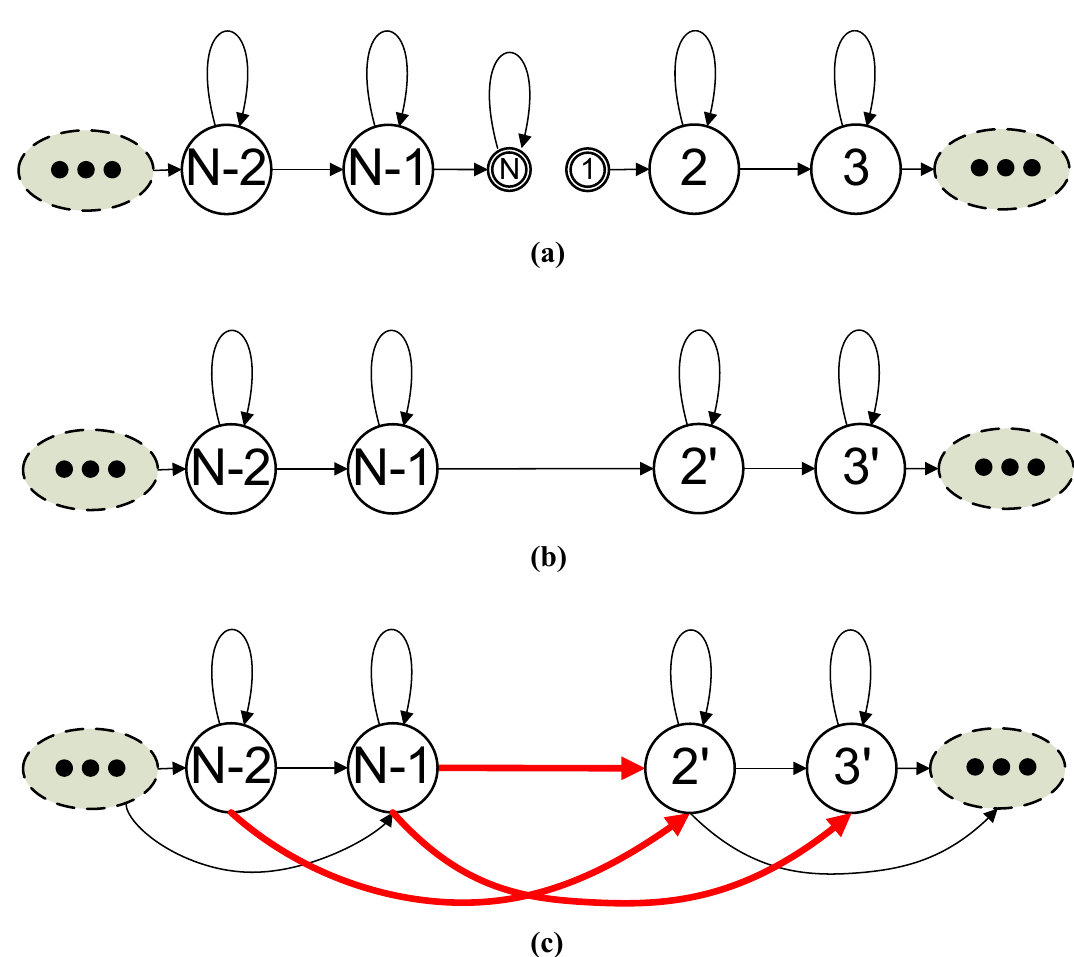
Fig 4. Illustration of the connecting-then-adapting approach for HFR adaptation of HMMs. (a) Two individual original FFR HMMs. (b) The two individual HMMs are concatenated and then the passing-through null states are removed. (c) The adapted combined